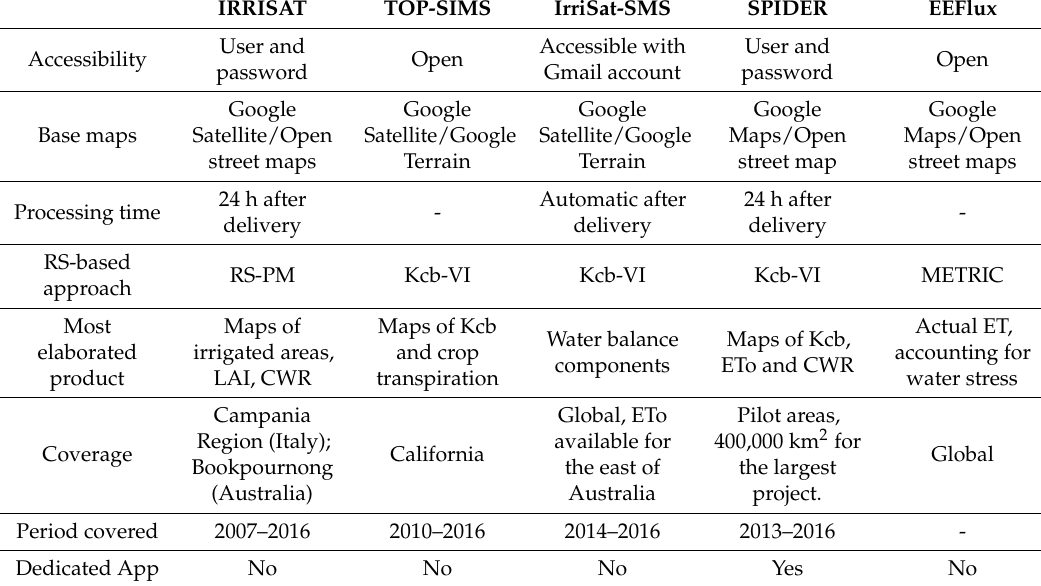
Table 2. Relevant aspects of the web-GIS-based decision support systems analyzed in the text. IRRISAT, Irrigation assisted by Satellite; TOP-SIMS, Terrestrial Observation and Prediction System Terrestrial Observation and Prediction System; IrriSat-SMS, Irrigation Water Management by Satellite and SMS; SPIDER, System of Participatory Information, Decision support and Expert knowledge for irrigation River basin water management; EEFlux, Earth Engine Evapotranspiration